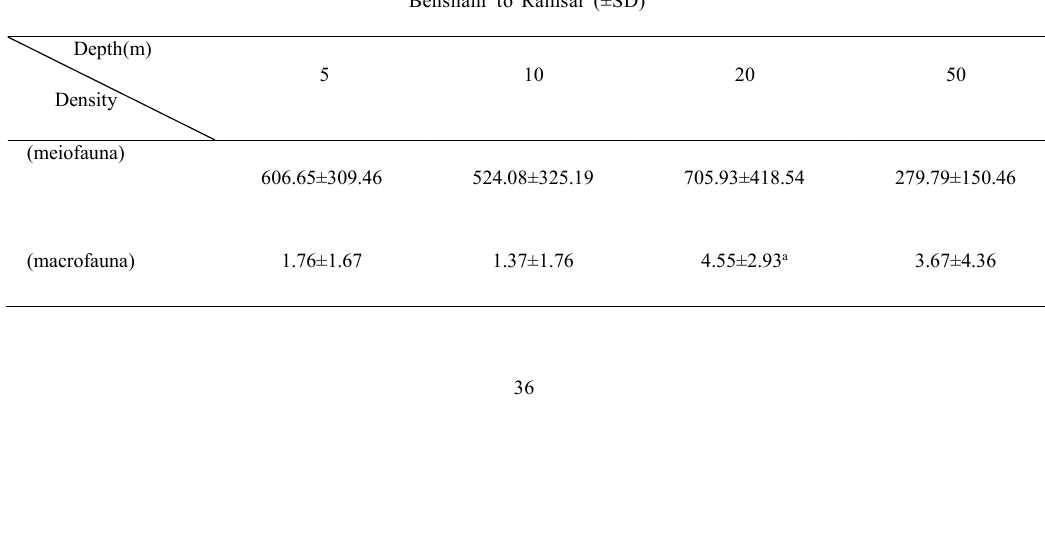
Table 8: Density of meiofauna and macrofauna in 10cm 2 of sediment indifferent depths in the southern Caspian Sea from Behshahr to Ramsar